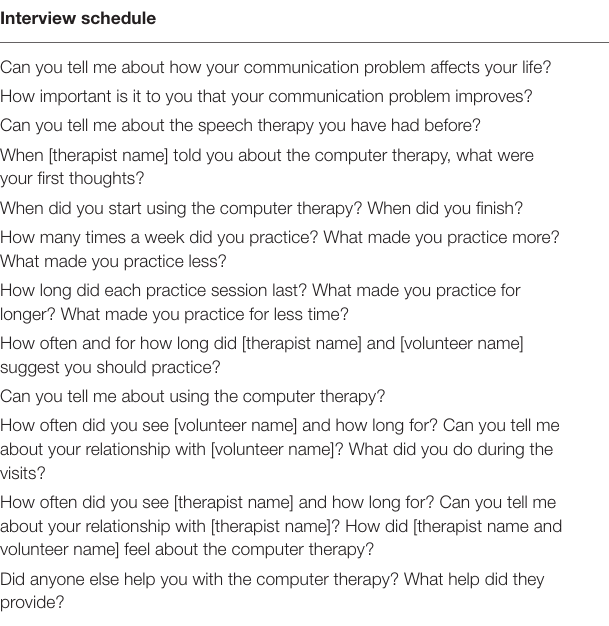
TABLE 1 | Summary of questions from the interview schedule. Interview